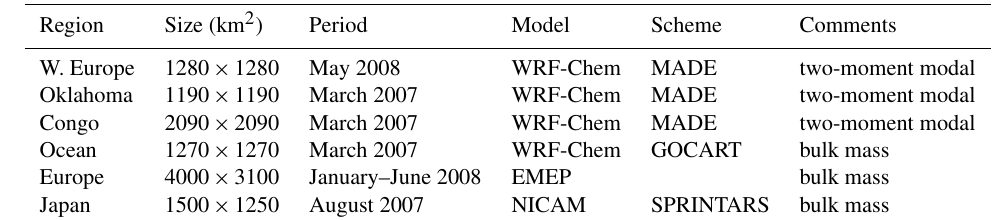
Table 1. Simulations analysed in this study.